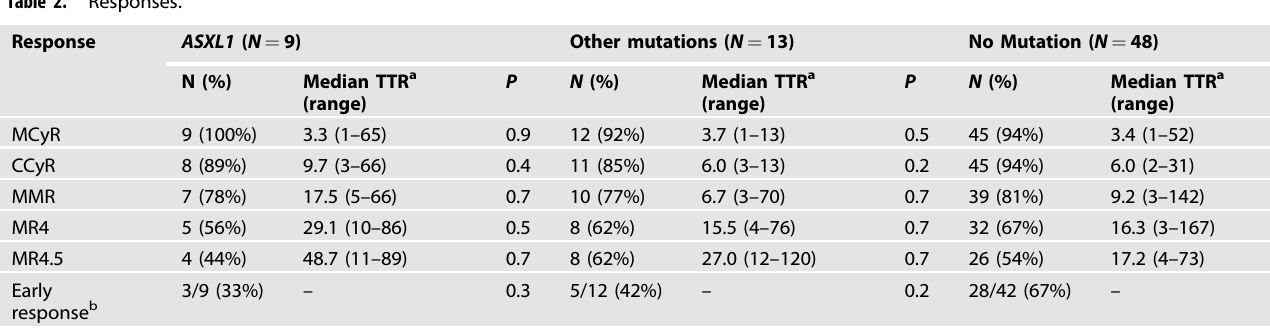
Table 2. Responses.